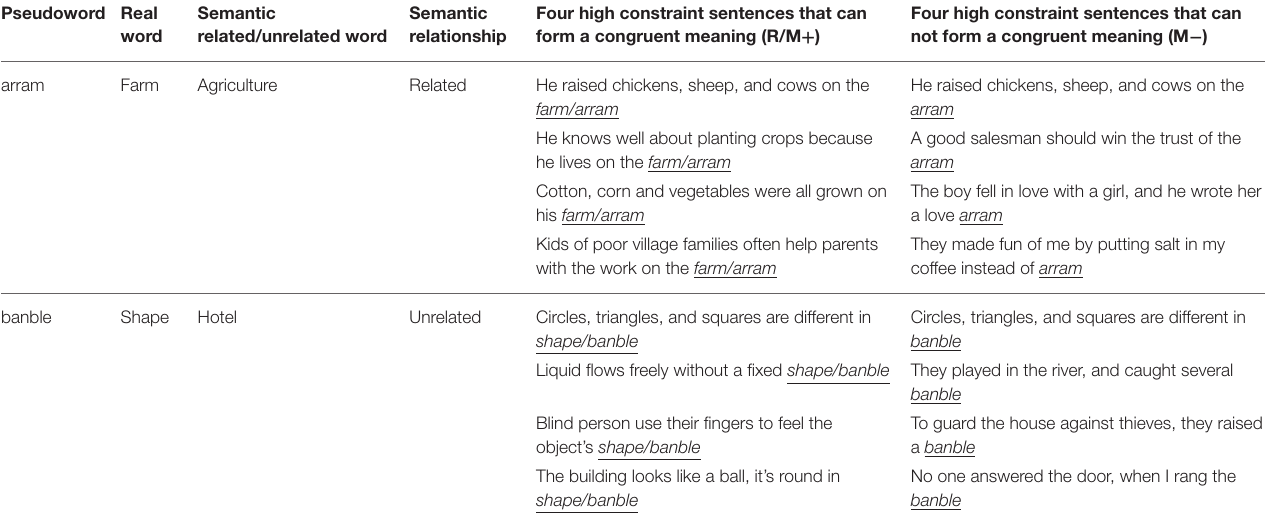
TABLE 1 | Examples of four sentences and test pairs of words from each condition. Pseudoword Real word